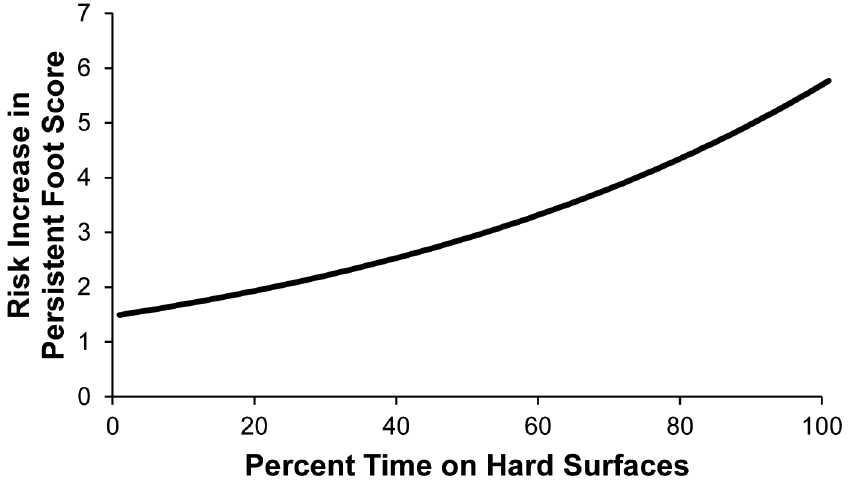
Fig 3. Risk increase for possible persistent foot scores by percent time on hard surfaces for an elephant 25 years old, where Percent Time In/Out Choice during the day and Space Experience at night are kept to average (8.52% and 22097.91 ft 2 ,